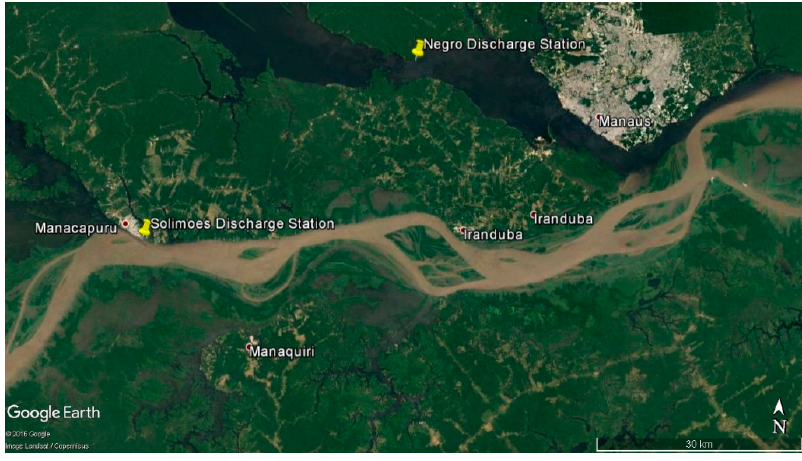
Figure 2. Location of the Tatu-Paricatuba and Manacapuru stations.